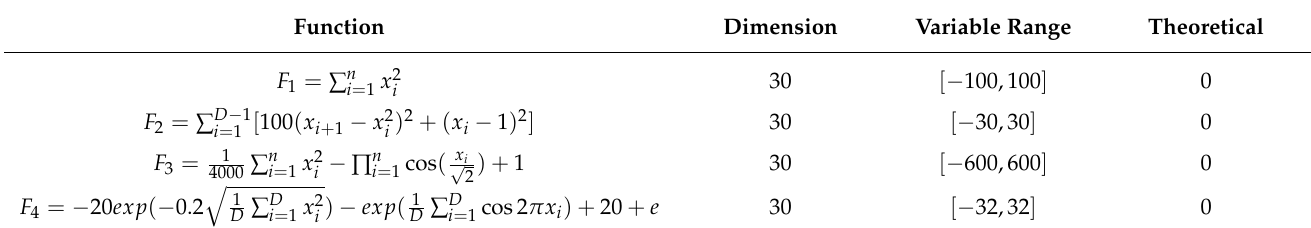
Table 1. Standard test functions.